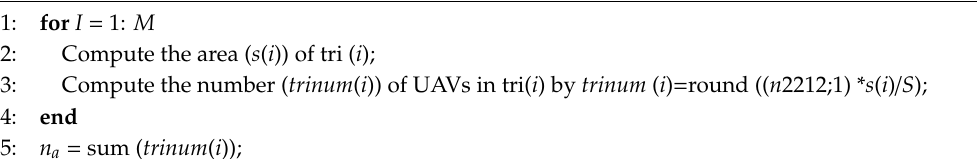
Algorithm 2 The allocation method for the remaining n − 1